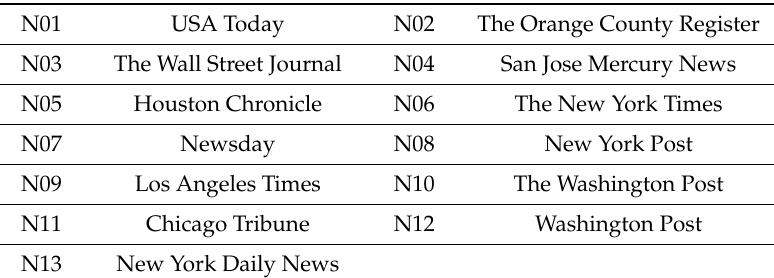
Table 8. The code table for news sources.